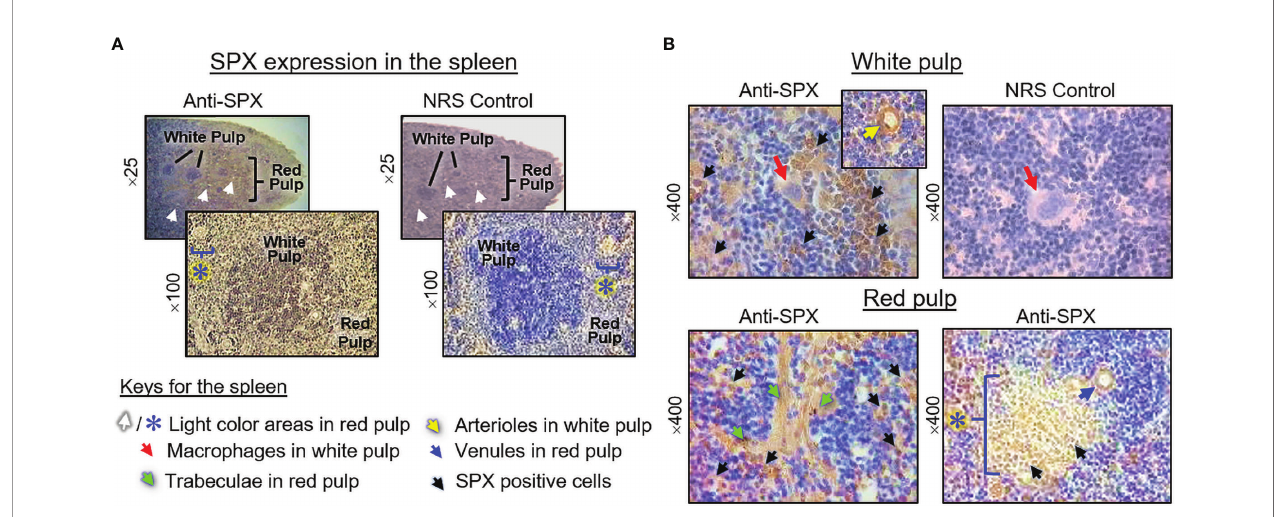
FIGURE 12 | Histological distribution of SPX expression in the spleen. (A) SPX immunoreactivity detected by anti-SPX in different areas of the mouse spleen covering the white pulp and red pulp. (B) SPX expression in different cell types within the white pulp and red pulp. SPX signals could be located in the macrophages and distinct cell clusters within the white pulp (upper panels). In the red pulp, SPX immunostaining was detected in the trabeculae and cell clusters in their neighborhood as well as in the light color areas scattering among the red pulp. SPX signals were also observed in endothelial cells and muscle layer of the arterioles in the white pulp/venules in the red pulp. In this study, parallel staining with NRS was used as negative control and the numbers on the side (×25, ×100, ×200, and ×400) represent the magni fi cation of the respective pictures.